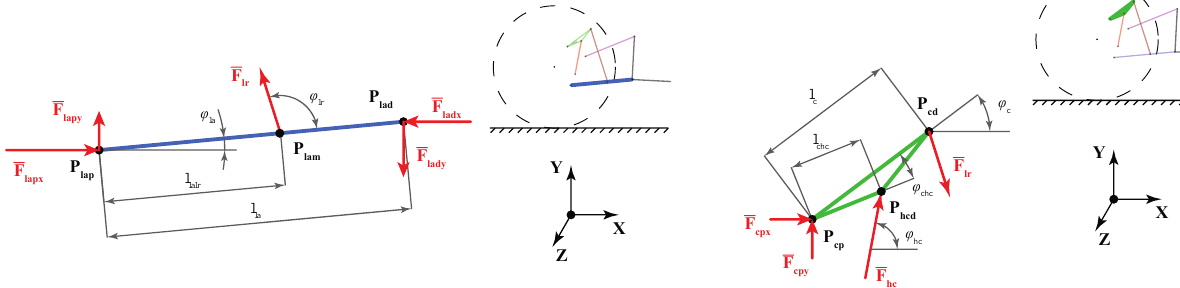
Figure 5. TPH model. ( a ) Lower arms; ( b ) lift arms.